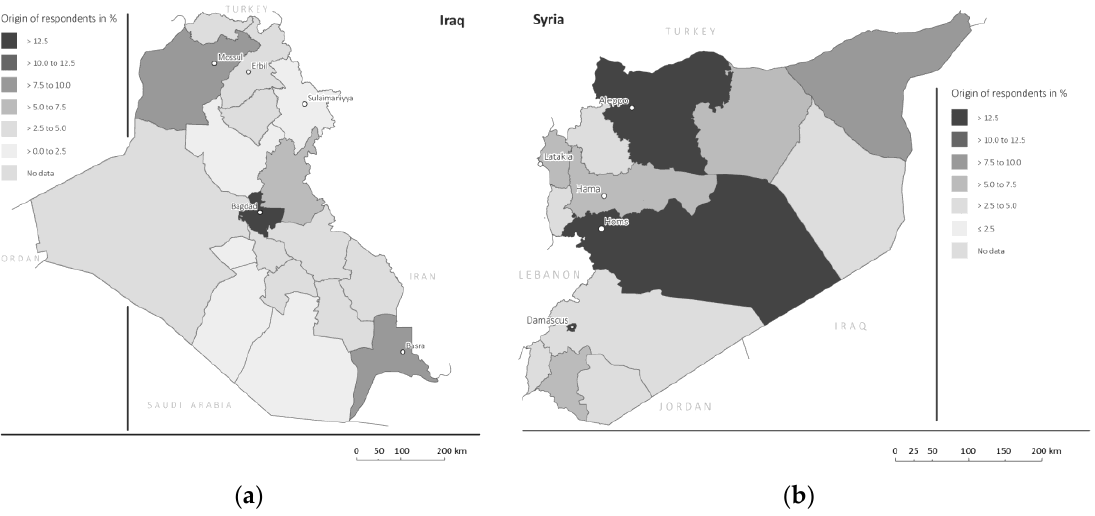
Figure 1. Origin of adult Iraqi ( a ) and Syrian ( b ) respondents. Source: DiPAS ( n = 196 Iraqi and 184 Syrian individuals).